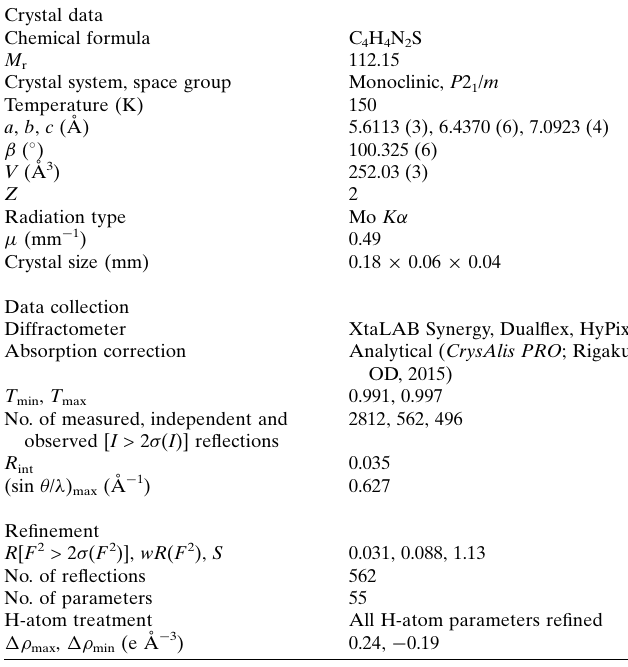
Crystal data Chemical